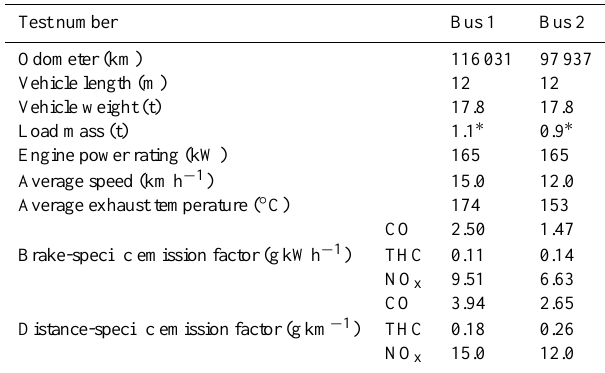
Table 5. Summary of information of two tested Euro IV buses with data regarding with real-time engine conditions recorded by OBD